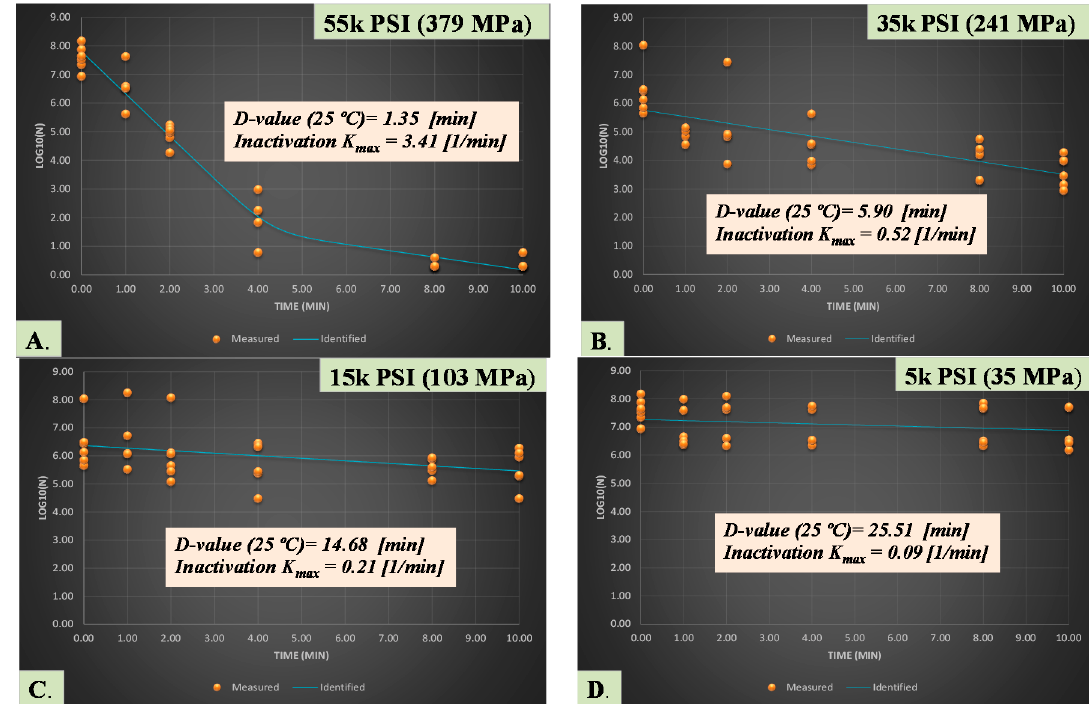
Figure 4. Inactivation rates for five-strain mixture (ATCC ® numbers 13076, 8387, 6962, 9270, 14028) of habituated Salmonella serovars exposed to elevated hydrostatic pressure (Barocycler Hub 440, Pressure BioScience Inc., South Easton, MA, USA) in sterilized orange juice. K max values are selected from best fitted model (goodness-of-fit indicator of R 2 values, α = 0.05) using GInaFiT software. K max values are expression of number of log cycles of reduction in 1/min unit, thus larger values indicate less time required for microbial cell reductions in each tested level of hydrostatic pressure. D-values provided are calculated based best fitted linear model, indicating time required for one log (90%) of microbial cell reductions of the habituated microbial mixture. ( A ). Treatment at 55K PSI (380 MPa) with R 2 = 0.97; ( B ). Treatment at 35K PSI (241 MPa) with R 2 = 0.85; ( C ). Treatment at 15K PSI (103 MPa) with R 2 = 0.74; ( D ). Treatment at 5K PSI (35 MPa) with R 2 = 0.77.